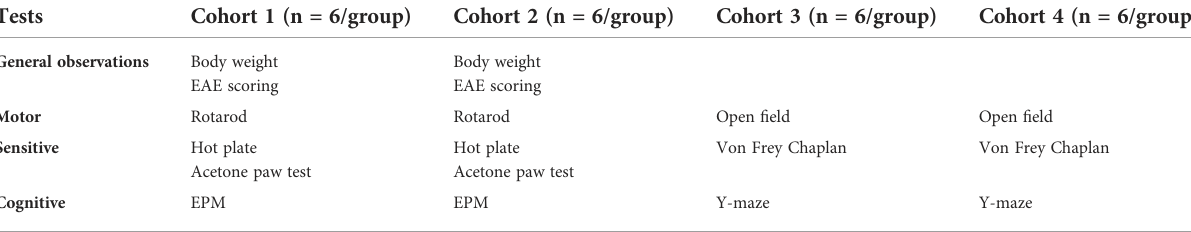
TABLE 1 Summary table of tests performed by